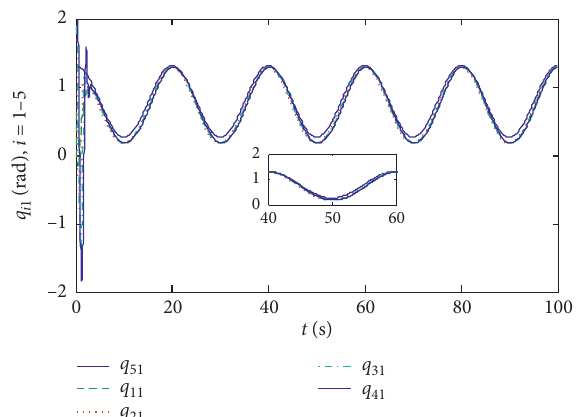
Figure 3: The generalized coordinates q